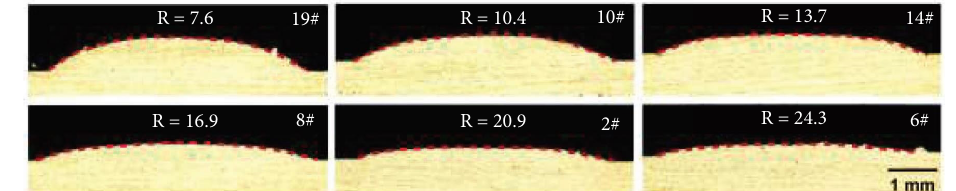
Figure 8: Contours of the track cross-section with diferent R (the ratio of W consistent with Table